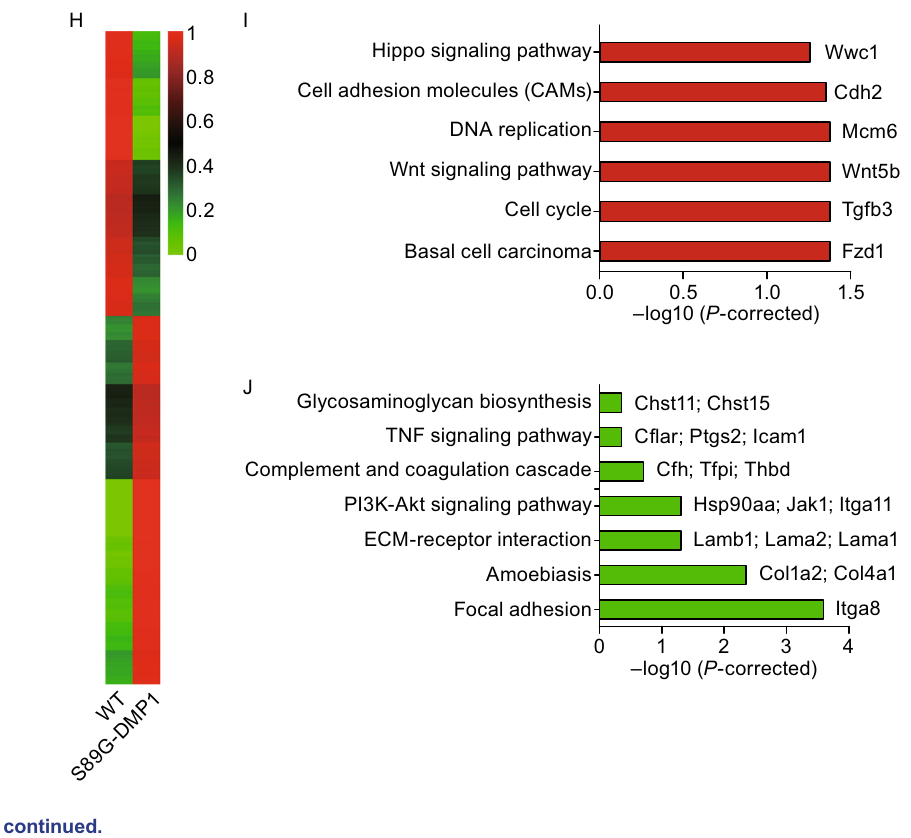
(Fig. S5C – F). These changes protected BBB to resist the osmotic pressure of mannitol on the opening of the blood- brain